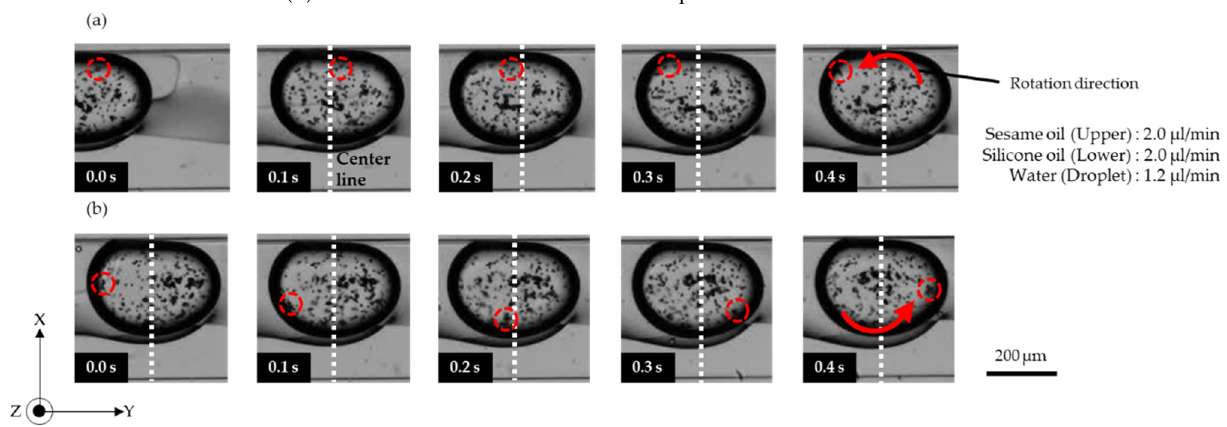
Figure 4. Images of anti-clockwise rotation of a microdroplet. ( a ) Upper beads in the droplet; ( b ) lower beads in the droplet.